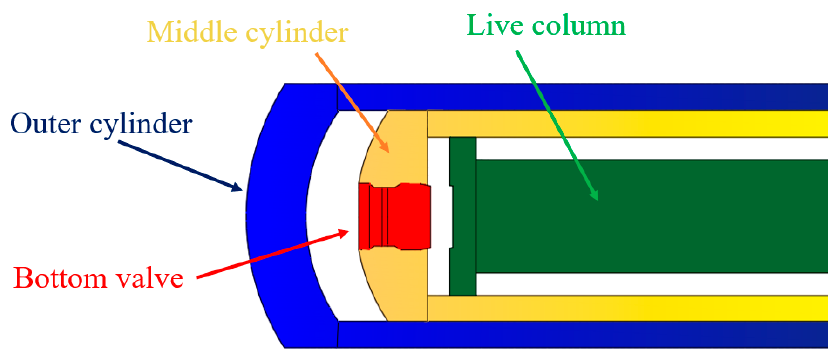
Figure 6. Bottom valve position.